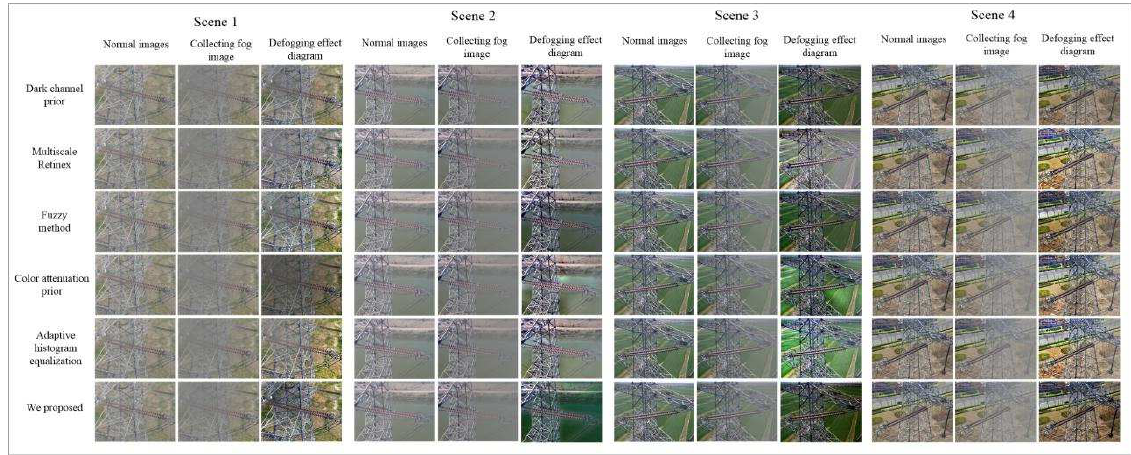
Figure 12. Visualization of execution effects of various algorithms in different environments.